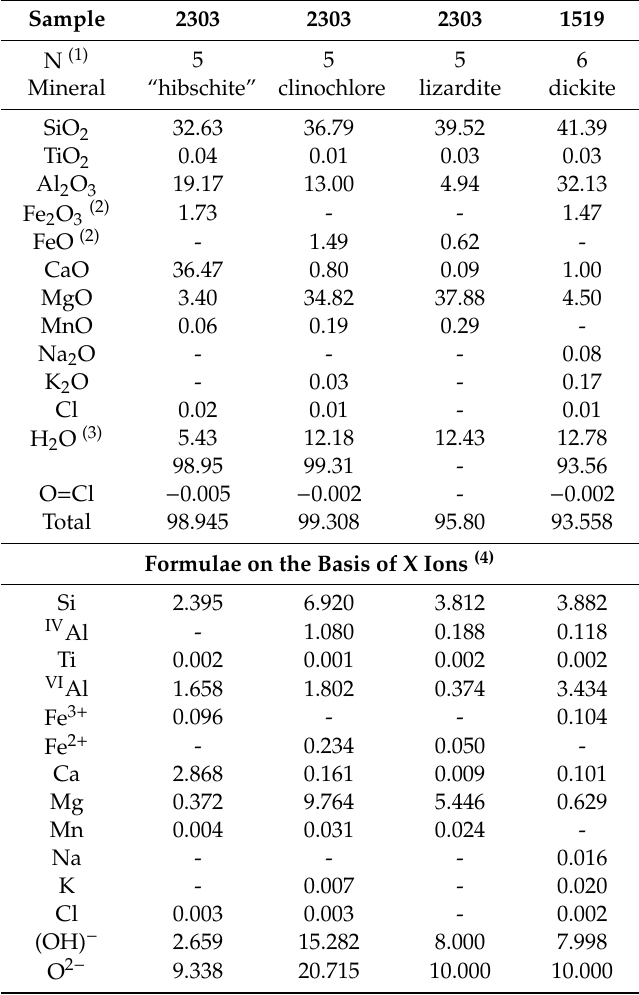
Table 12. Representative compositions of selected secondary minerals in the M ă gureaua Va¸tei skarns *.